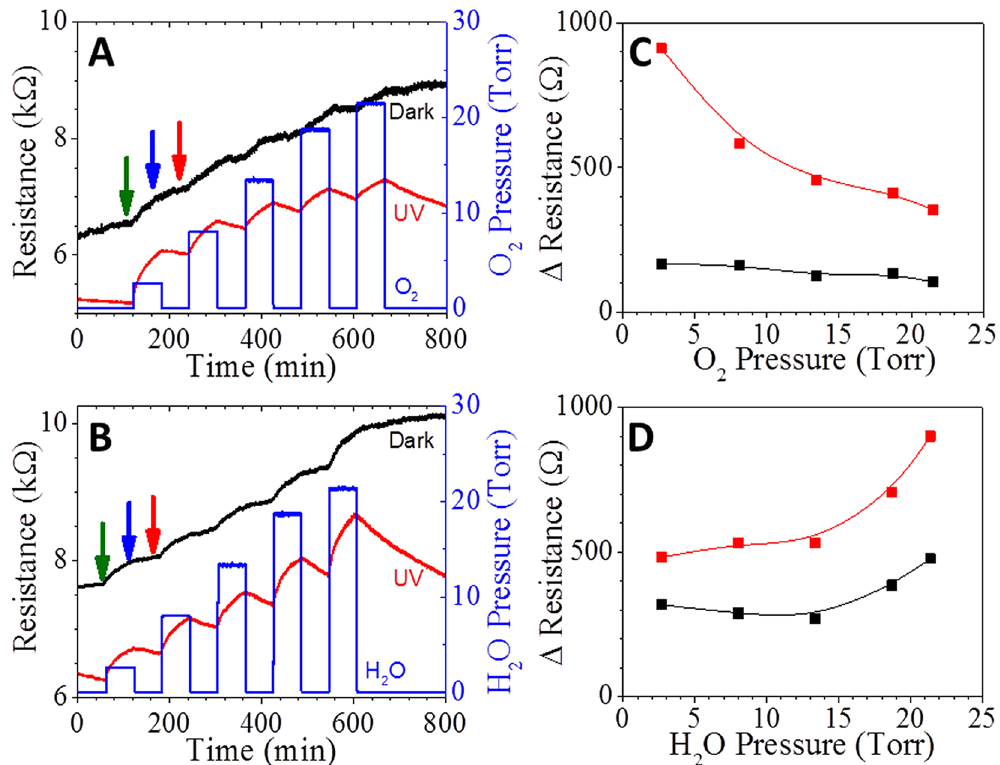
Figure 3. Resistive response of ZnO films, in dark (black) and UV (Red) conditions, to pulses of increasing pressures of O 2 ( A ) and H 2 O vapor ( B ). The pressure of analyte pulses are depicted by blue traces. Green, blue and red arrows represent the point where full impedance spectrum were measured (shown in Fig. 4). Relative resistance responses to O 2 ( C ) and H 2 O ( D ) pressure pulses, referenced to vacuum, were determined from the change in resistance from immediately before the pulse to the end of the pulse. UV Irradiation has an exponential effect on the O 2 trend, while irradiation did not appear to change the H 2 O trend, but simply increased the resistive response. The decrease in response to increasing O 2 partial pressure is similar to the response of consecutive pulses of a single O 2 partial pressures (Figure S2), suggesting that it may be related to deoxygenation of the film during the UV cleaning process, prior to